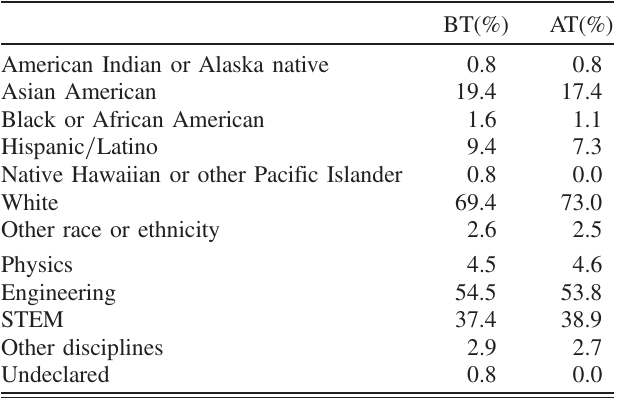
TABLE III. Demographic data of the men enrolled in the introductory physics lab course in its BT (Fall 2016 to Fall ¼ 382 and 2017) and AT (Spring 2018 to Fall 2019) format with N BT 1067 and N ¼ 1201 AT